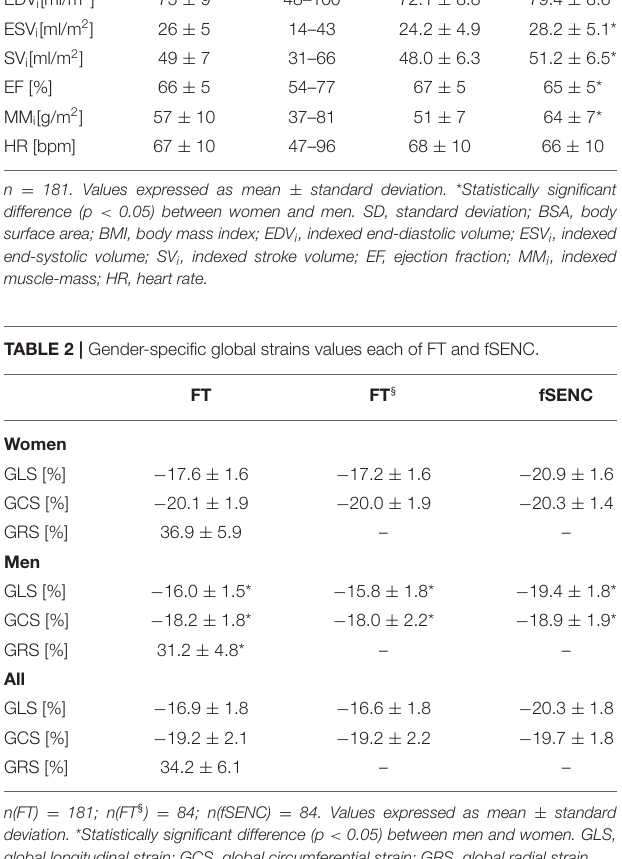
Figure 3 ). Spearman’s Rho showed a small correlation with age for FT-GCS ( ρ = − 0.134, p = 0.07) and significantly for FT-GRS ( ρ = 0.152, p = 0.04), but no correlation for FT-GLS ( ρ = − 0.069, p = 0.35). Percentile curves for all global strain values are shown in Figure 4 . Muscle